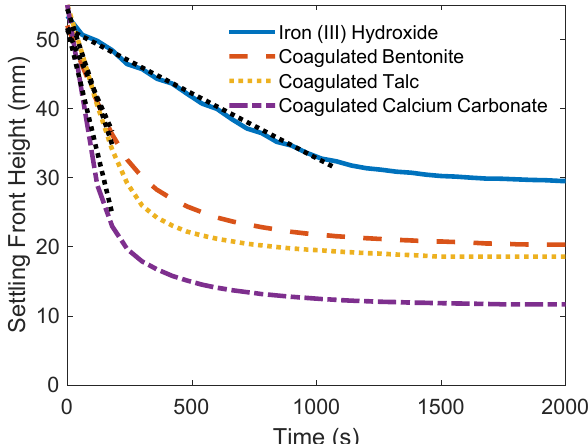
Figure 6. Settling front height versus time for coagulated modified bentonite, talc and calcium carbonate, as well as pure iron hydroxide flocs (dotted black lines indicate fits to obtain settling rates).